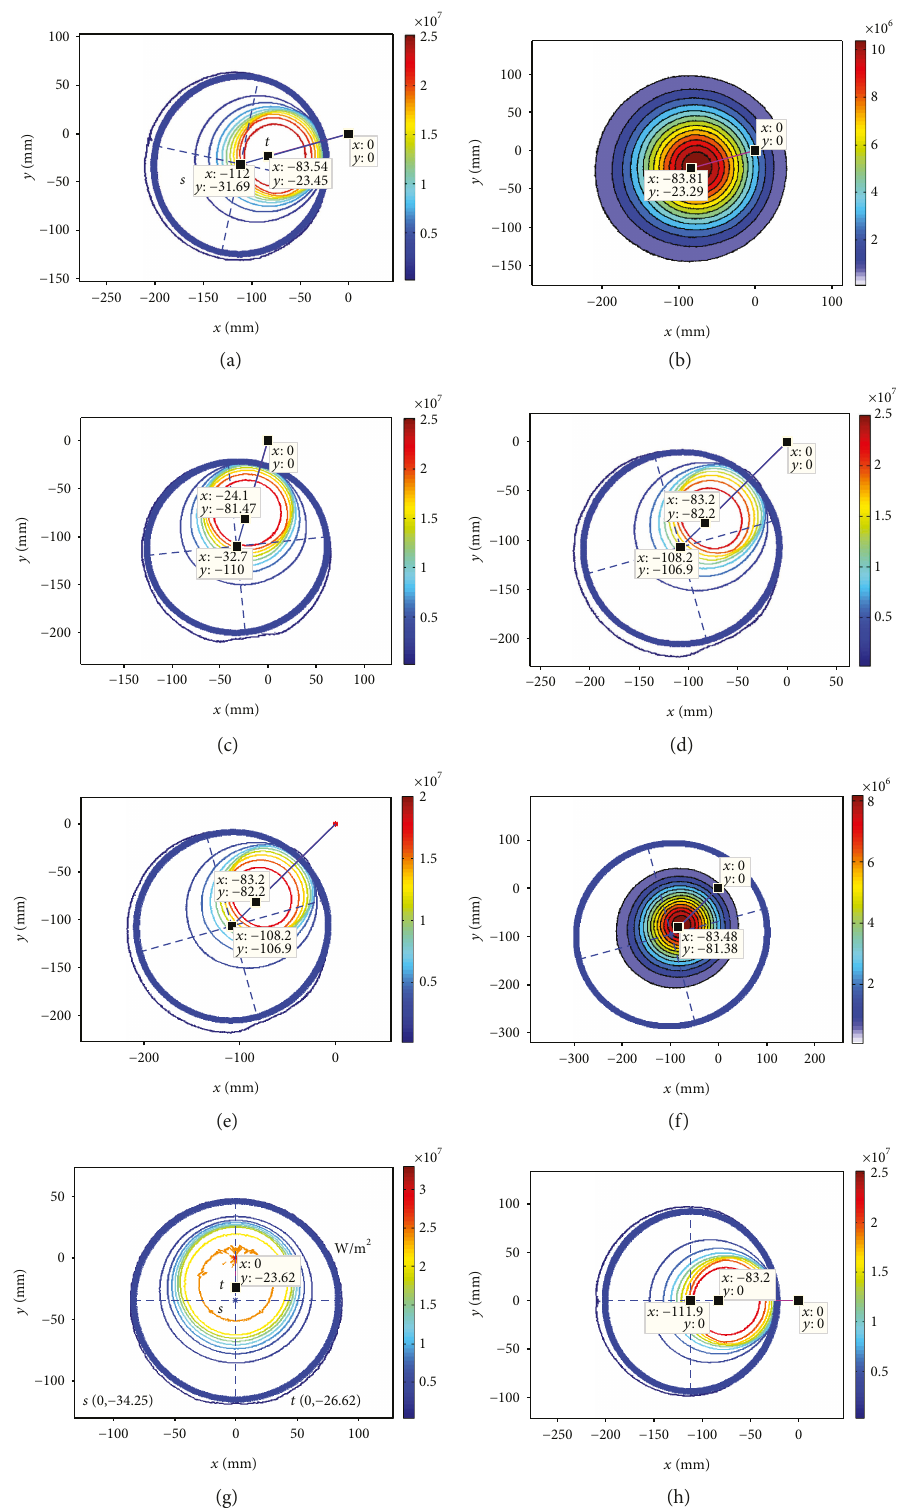
Figure 8: The fl ux distribution of the focal plane under the EATD tracking error (W/m 2 ). (a) σ = 0 , β = 30 ° , ε σ = 2 mrad, β = 30 ° , ε ε =6.9mrad; (e) σ = 0 , β = 0 ° , ε 2 =800W/m 2 ; (g) σ = 0 , β = 0 ° , ε W 0 only Figures 8(e) and 8(f) are with W